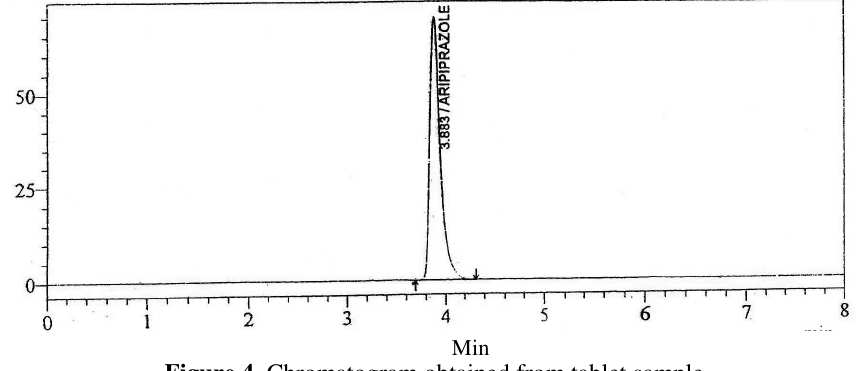
Figure 4. Chromatogram obtained from tablet sample.